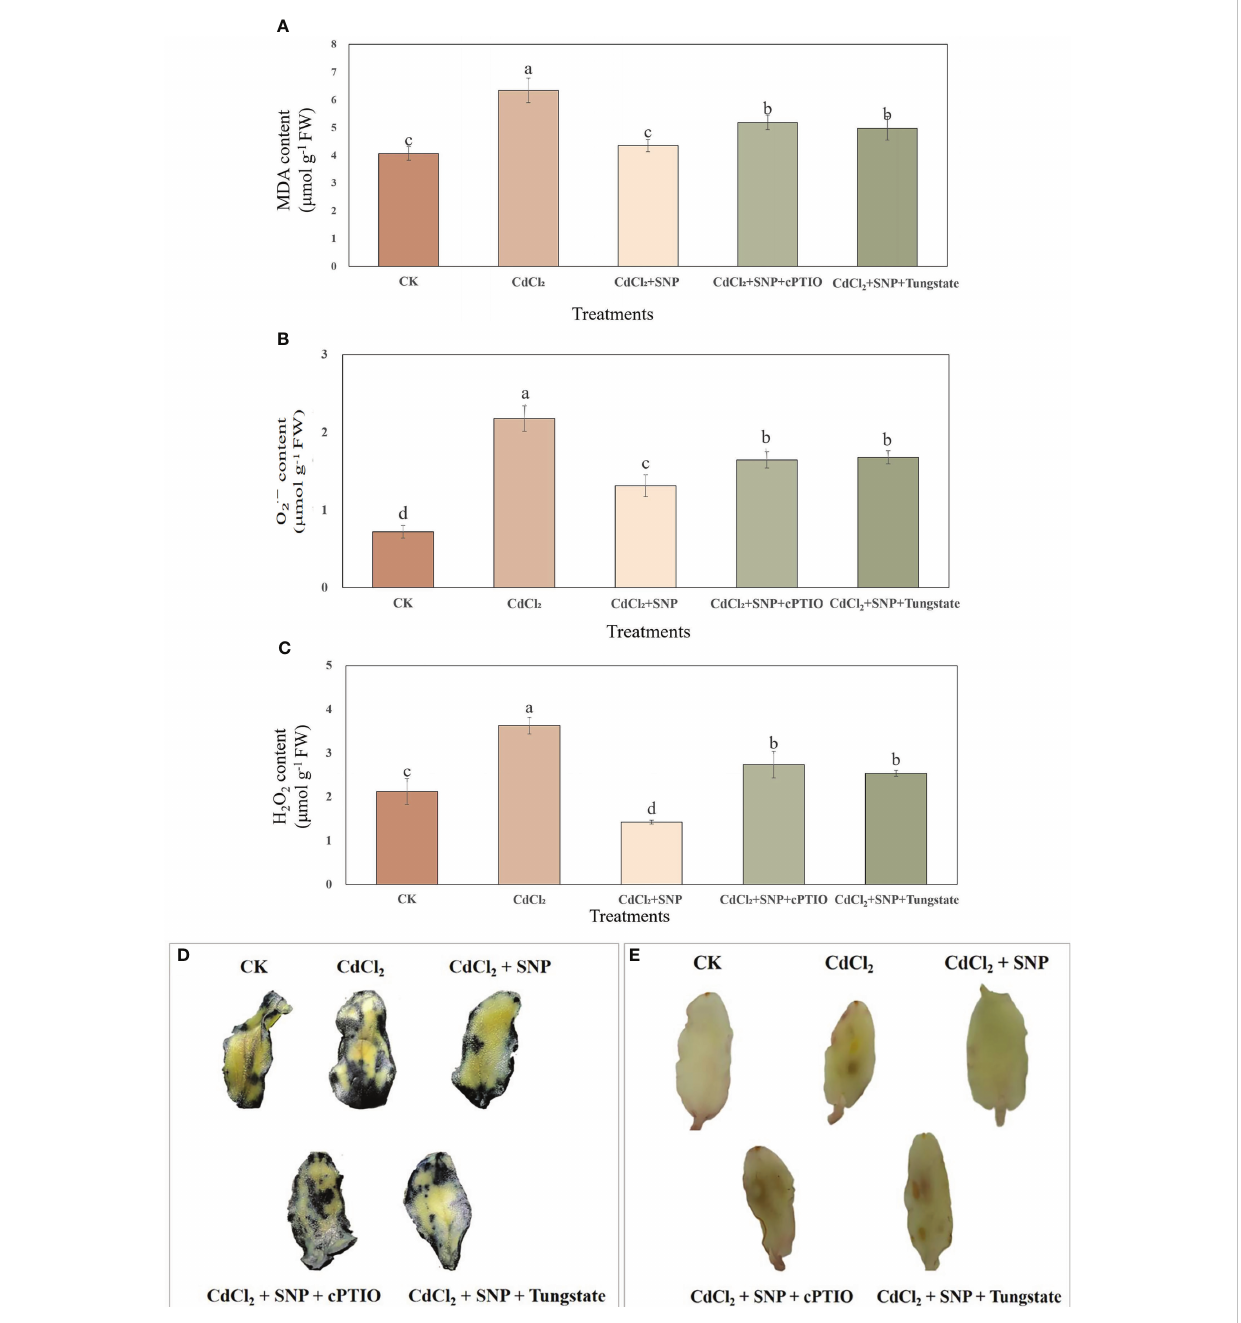
FIGURE 4 Effect of NO on MDA content ( A ), O · − 2 content (B) and H 2 O 2 content (C) during adventitious root development in cucumber under Cd stress. Explants were incubated for 48 h with distilled water (CK) or 1 m M CdCl 2 , 1 m M CdCl 2 +10 m M SNP, 1 m M CdCl 2 + 10 m M SNP + 200 m M cPTIO, 1 m